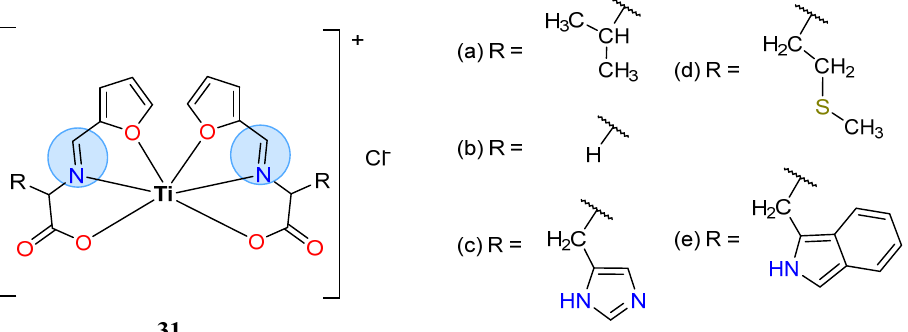
Figure 14. Ti(III) complexes with 2 ‐ furfuraldehyde studied for their antimicrobial activity. Complex with ( a ) Valine; ( b ) Glycine; ( c ) Histidine; ( d ) Methionine; ( e ) Tryptophan. The fungicidal activity of bis(cyclopentadienyl) titanium(IV) chloride compounds with SBs derived from 2 ‐ amino ‐ 5 ‐ phenyl ‐ 1,3,4 ‐ thiadiazole with 2 ‐ hydroxybenzaldehyde or